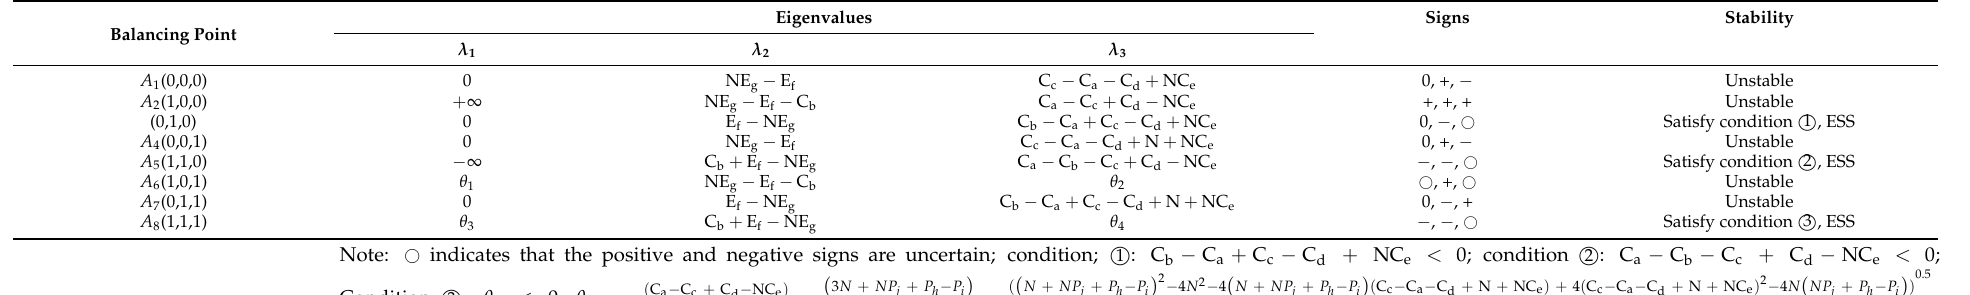
Table 6. Strategic Portfolio Stability Analysis under Miner Pessimism, Government and SMEE Rational Scenarios.